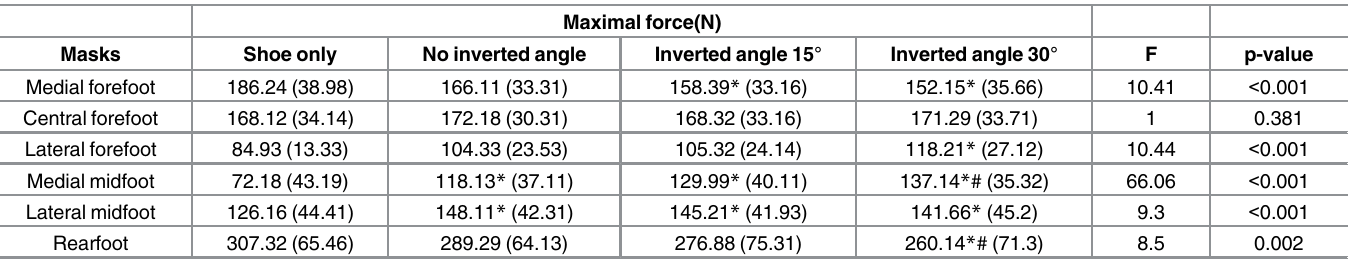
Table 3. Maximal forces of the 6 mask areas in each foot orthotic condition.